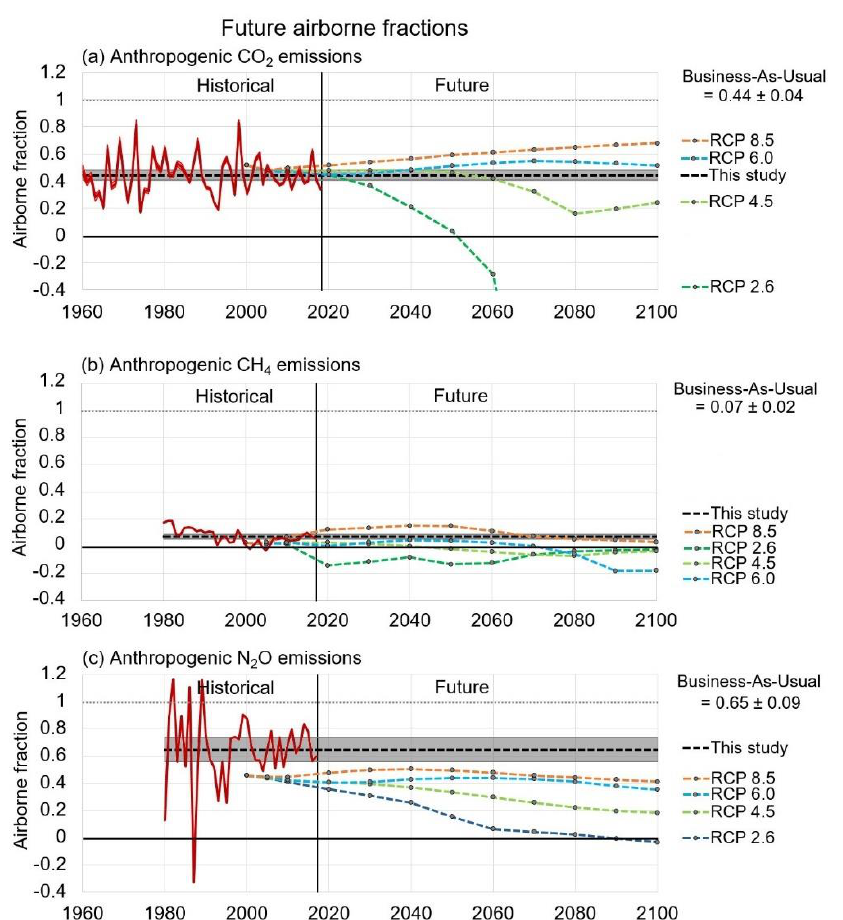
Figure 9. Comparison of the future airborne fractions implied by each of the IPCC AR5’s RCP scenarios to our projected “Business-As-Usual” ranges for: ( a ) carbon dioxide (CO 2 ); ( b ) methane (CH 4 ); and ( c ) nitrous oxide (N 2 O). The horizontal axes correspond to years. Details on the projections are provided in Table 2.